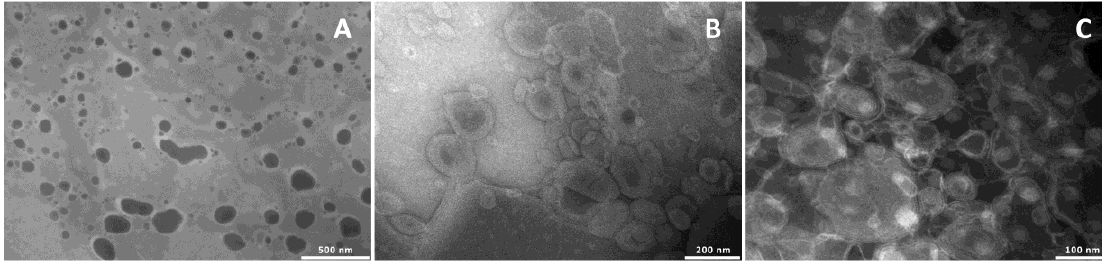
Figure 1. TEM images of pompia extract loaded liposomes ( A ), glycerosomes ( B ) and PG-PEVs ( C